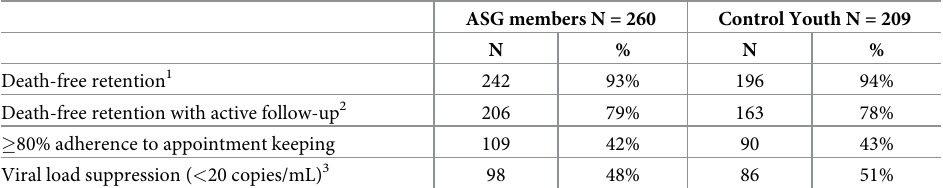
Table 3. Twelve-month clinical outcomes (N = 469).